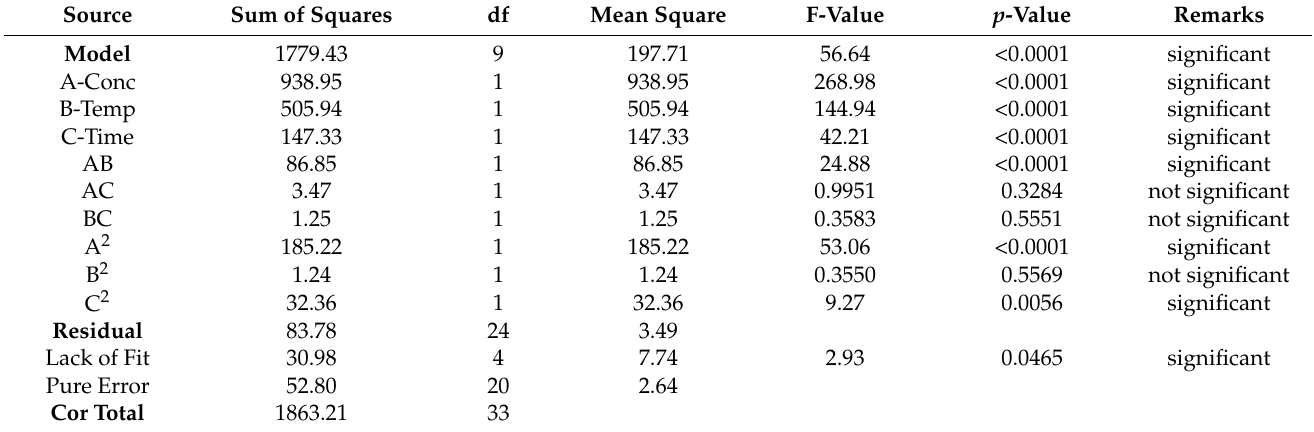
Table 9. ANOVA for Nd Extraction.